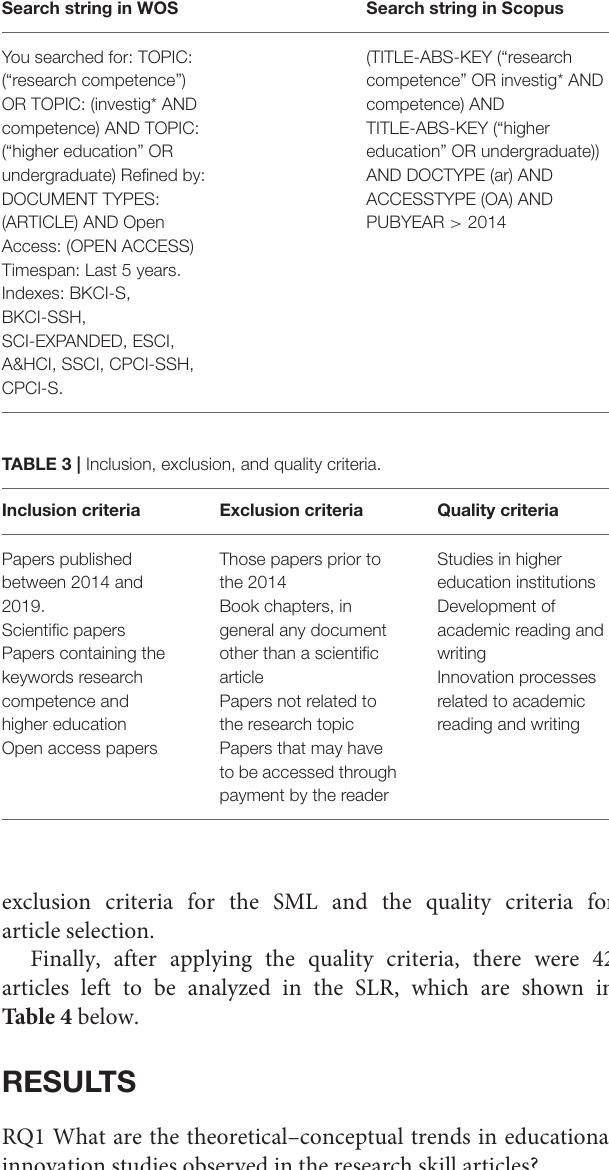
TABLE 1 | Research questions and kind of answers in the systematic literature review.